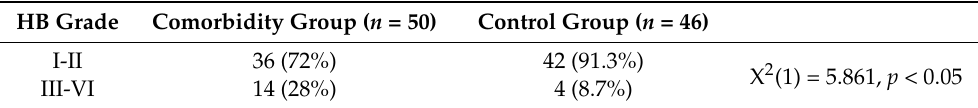
Table 4. Initial and final House–Brackmann (HB) of Bell’s palsy in the study group (comorbid diseases: diabetes mellitus, hypertension, and hypercholesterolemia), and the control group.